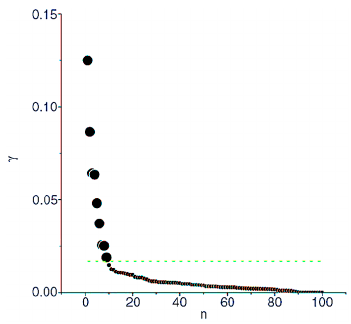
Figure 3. Decision graph for assuming cluster centers. γ i = ρ i θ i is the combination of local density ρ i and clustering distance θ i of service i . n is the index of services after they are sorted in descending order by γ